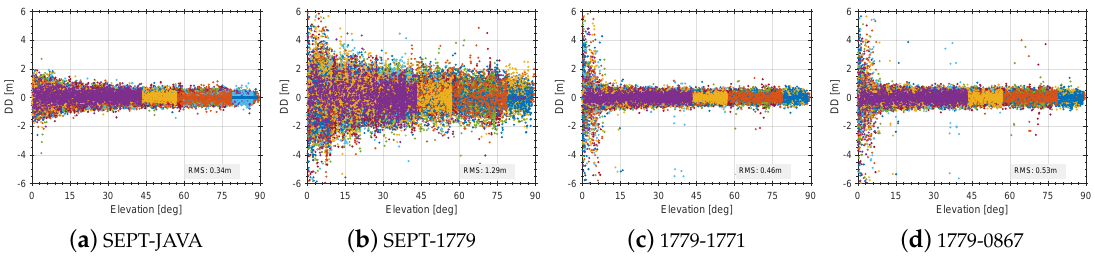
Figure 7. Double difference residuals of code observables on C/A versus the elevation for selected receiver combinations on the frequency L1 and signal C/A, system